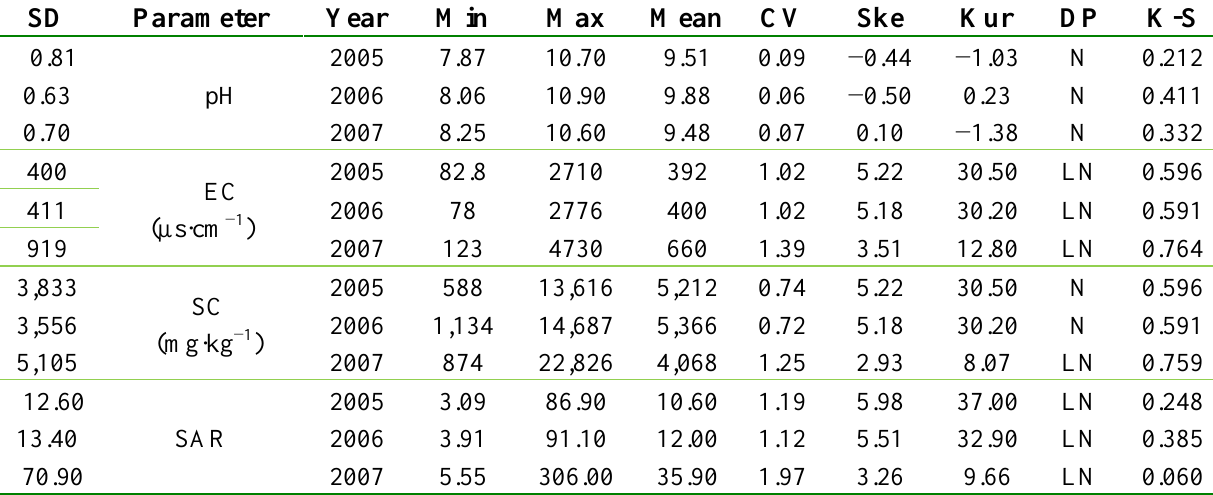
Table 1. Descriptive statistics on salinization patameters from 2005 to 2007